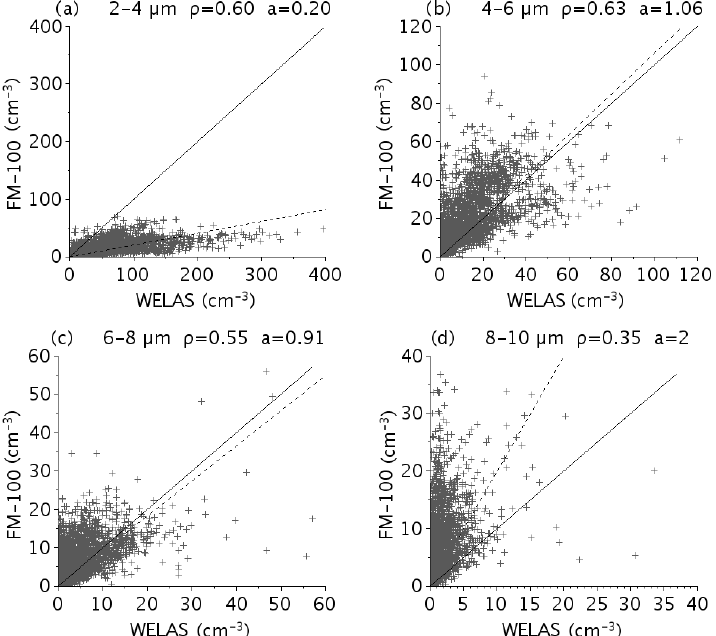
Figure A1. Scatterplot of the 5min average particle number concentration values as measured by the FM-100 for the four first bins vs. the integrated WELAS measurement over the corresponding diameter range (a) 2–4µm, (b) 4–6µm, (c) 6–8µm and (d) 8–10µm. The solid line corresponds to 1 : 1 line and the dashed line corresponds to best-fit line with correlation coefficient ρ and slope a , as indicated in the legend.